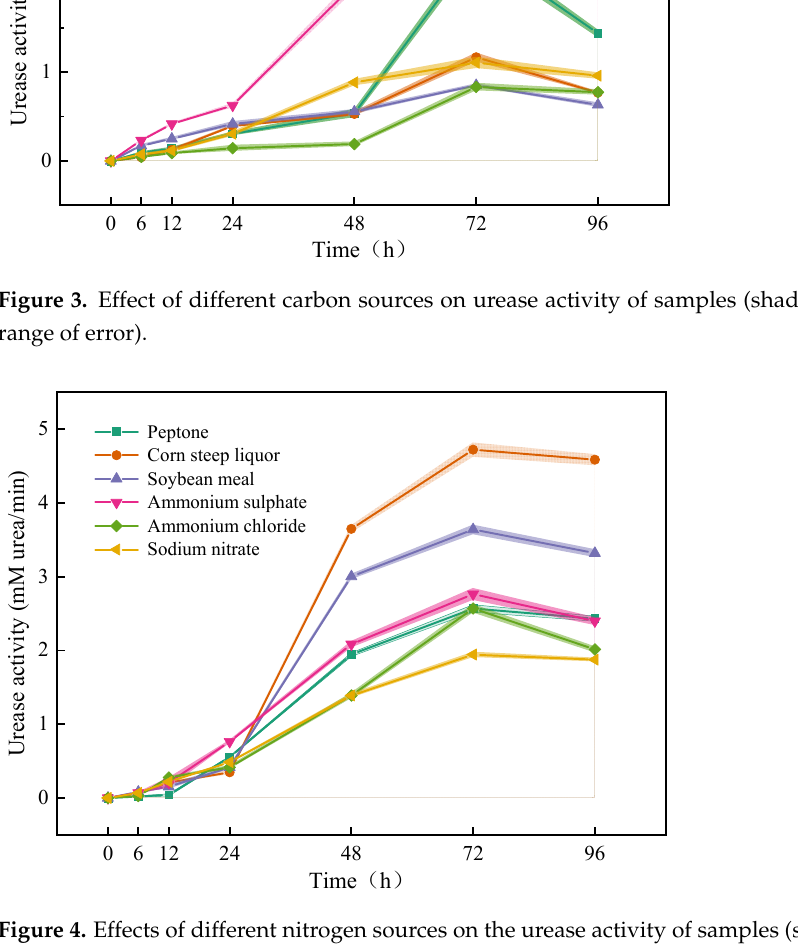
Figure 3. Effect of different carbon sources on urease activity of samples (shadows represent the range of error).